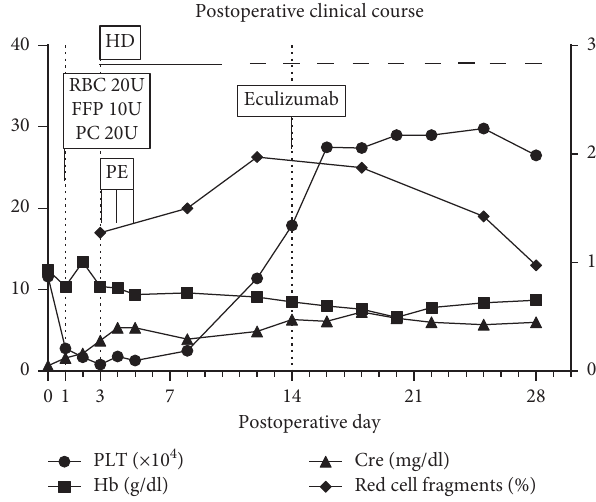
Figure 2: Graph shows the postoperative clinical course. Hb: haemoglobin, PLT: platelet count, Cre: creatinine, RBC: red blood cell, FFP: fresh frozen plasma, PC: platelet concentrates, HD: hemodialysis, and PE: plasma exchange.